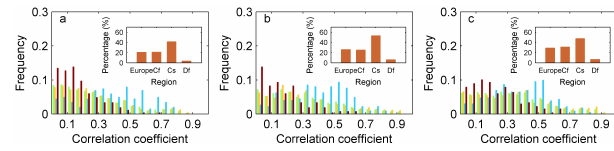
Figure 4. Frequency distributions of correlation coefficients of IAV of barley yield and IAV of the growing season’s (March–June) summed NDVI, GPP, and FAPAR in Europe (green bars) and cli- mate zones: Cf (yellow bars), Cs (light blue bars), and Df (brown bars). Percentage of pixels where there are significant ( p < 0 . 1) re- lationships between IAV of barley yield and IAV of the growing season’s summed NDVI, GPP, and FAPAR are shown in the inset